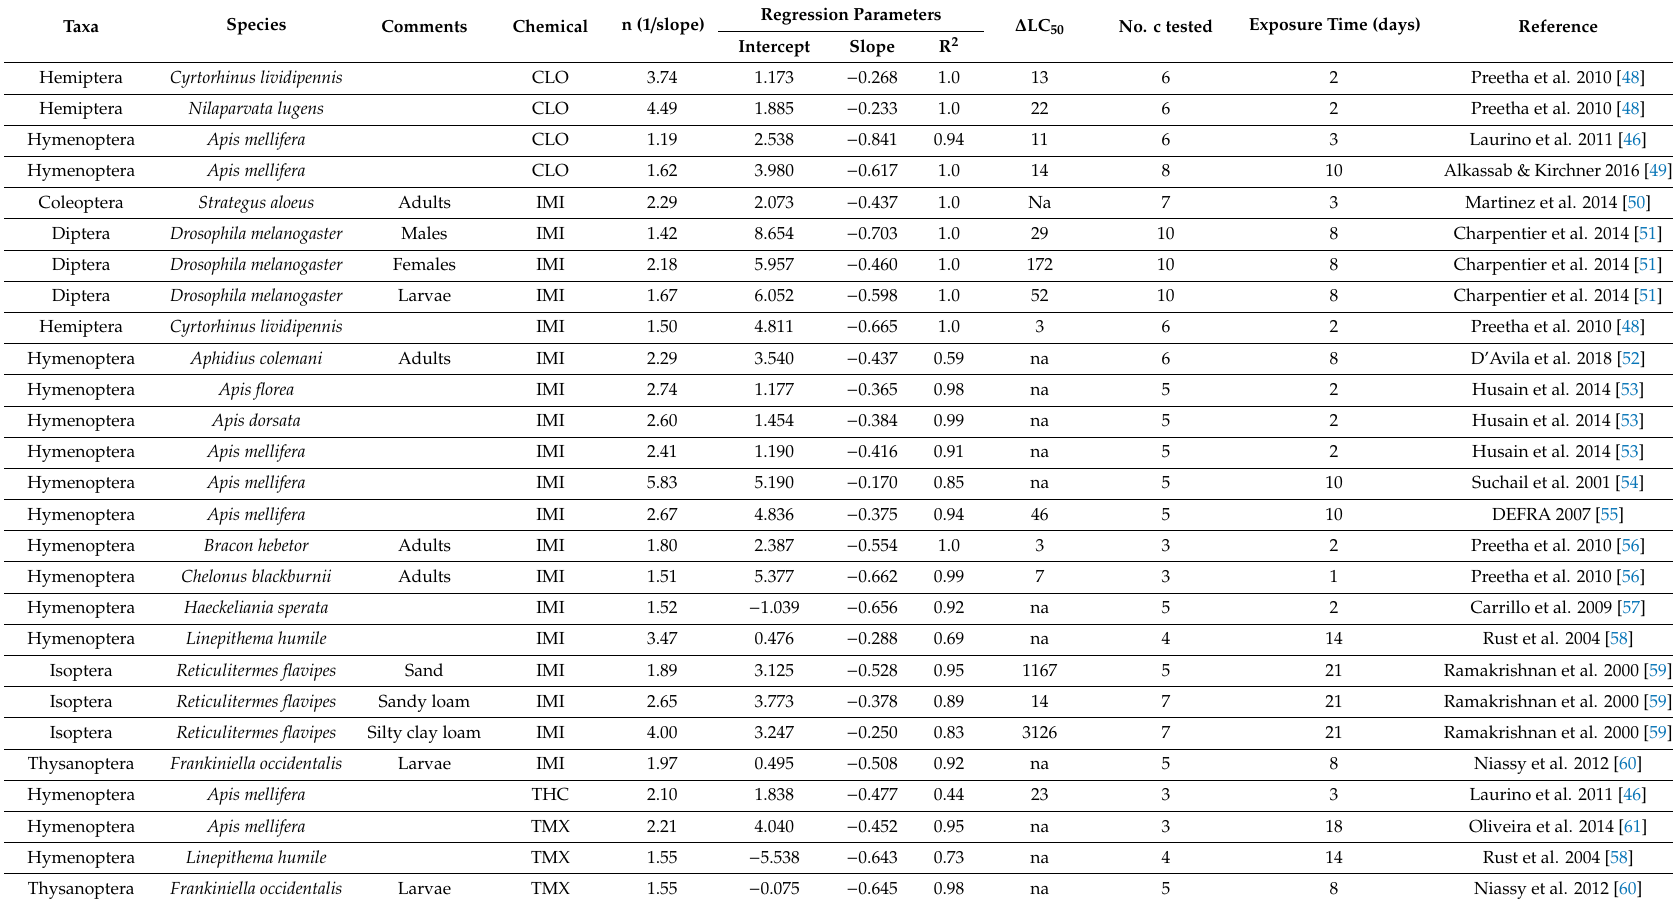
Table 4. Time-cumulative toxicity of neonicotinoids in terrestrial